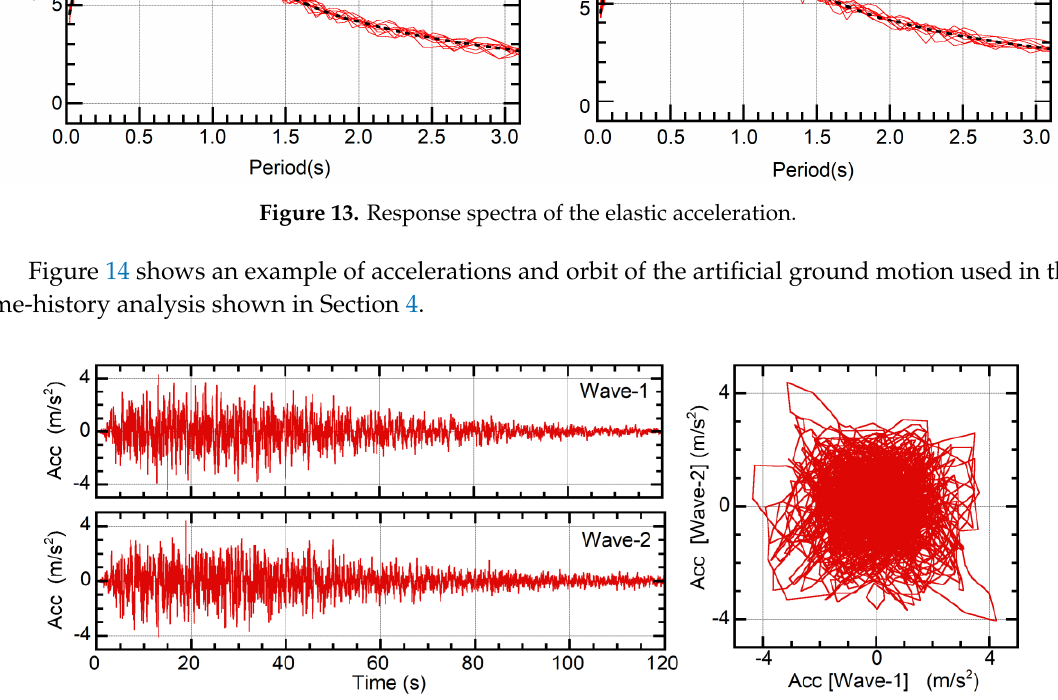
Figure 14. Example of accelerations and orbit of the artificial ground motion.